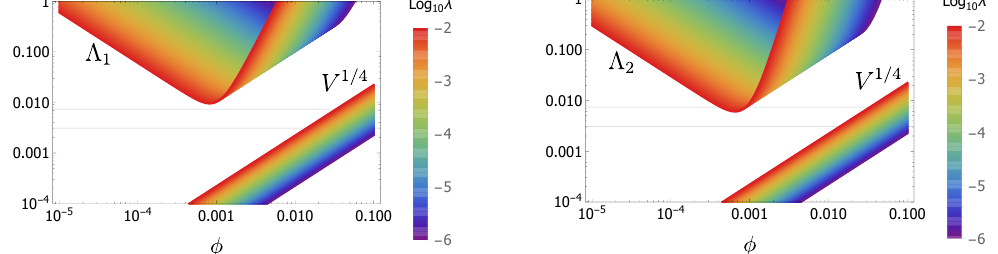
(a) Cuto(cid:11) from 2 ! 2 scattering of Goldstone bosons into Goldstone bosons ((cid:3) 1 in the left plot) and Higgs (cid:12)elds ((cid:3) 2 in the right plot).